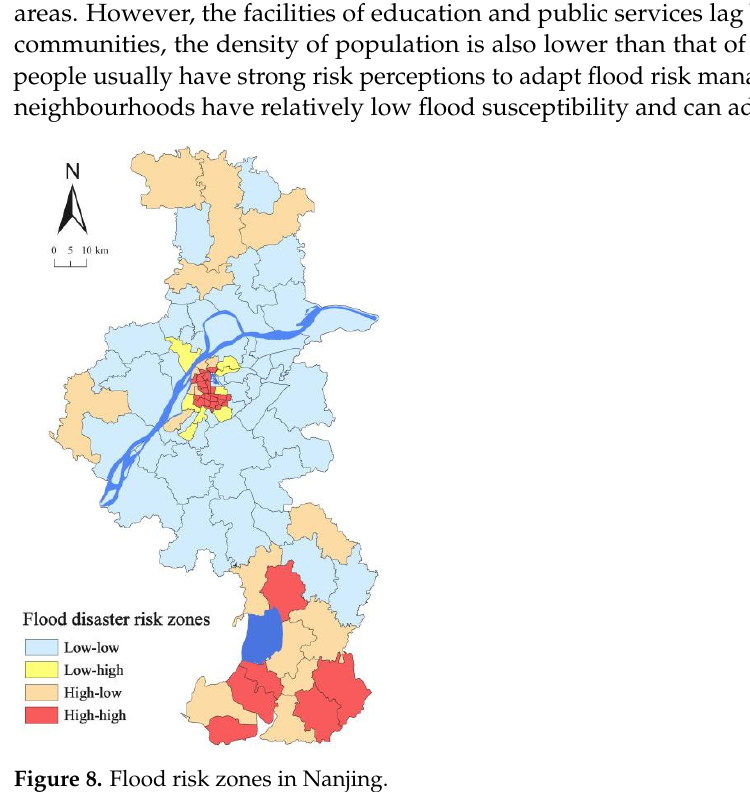
Figure 8. Flood risk zones in